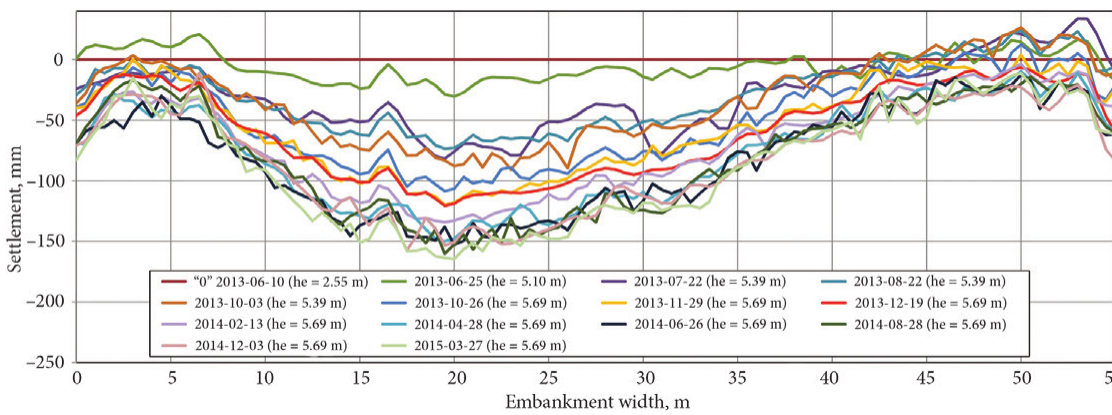
Fig. 10. Embankment settlement during construction (he – height of embankment)